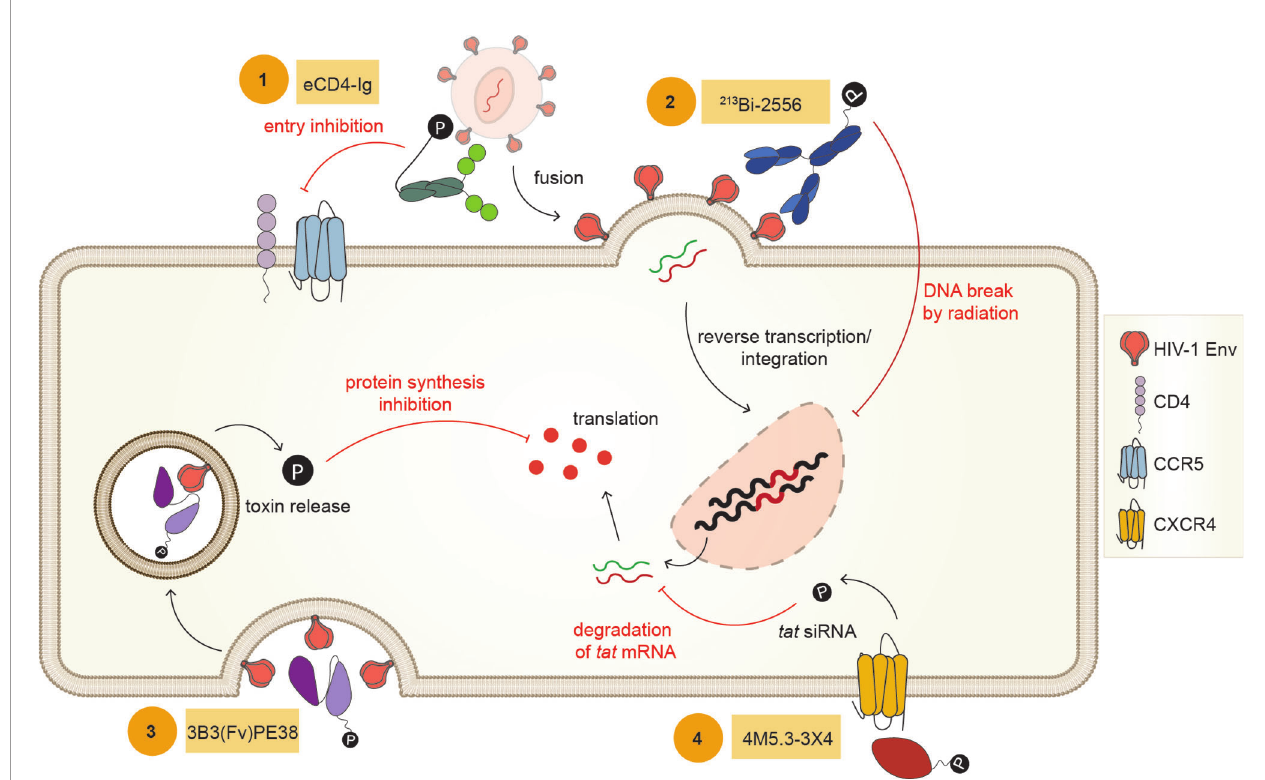
FIGURE 4 | Example of Antibody Conjugates. Representative antibody conjugates described in this review (1) eCD4-Ig is the conjugation of CD4 to a CCR5 mimetic peptide inhibiting viral fusion and entry, (2) 213 Bi-2556 is an antibody-radionuclide with 213 Bi fused to an antibody targeting gp41, this conjugate delivers cytocidal radiation upon binding inducing DNA break, (3) 3B3(Fv)PE-38 is an antibody-toxin constructed with the scFv subunit of b12 bNAb conjugated to PE toxin and functions by inhibiting protein synthesis upon internalization, (4) 4M5.3-3X4 is an antibody-oligonucleotide designed with a nanobody targeting CXCR4 conjugated with an anti- tat siRNA, inhibiting Tat-driven